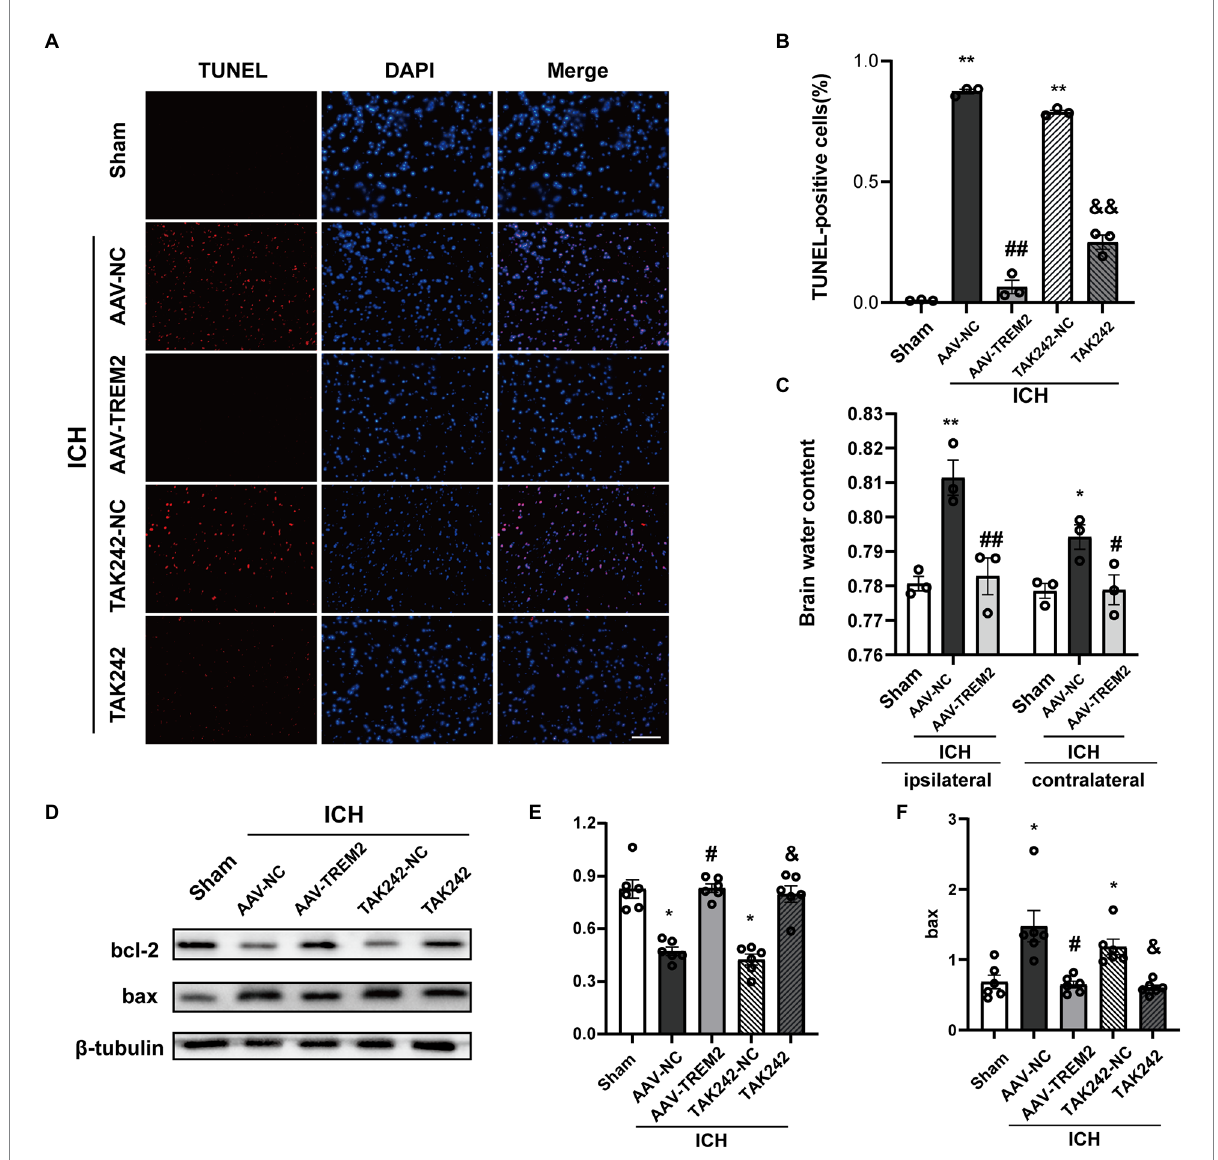
FIGURE 5 TUNEL staining and brain water content following intracerebral hemorrhage. (A,B) TUNEL staining of brain tissue (DAPI: blue, TUNEL: red), and quantitative analysis of TUNEL staining. ** p < 0.01, vs. the sham group, ## p < 0.01, vs. the AAV-NC + ICH group, && p < 0.01, vs. the TAK242-NC + ICH group. (C) Brain water content both in ipsilateral and contralateral hemisphere. ** p < 0.01, vs. corresponding sham group, # p < 0.05, ## p < 0.01, vs. the corresponding AAV-NC + ICH group. (D–F) Expression levels of bcl2 and bax in different treated groups, * p < 0.05, vs. the sham group, # p < 0.05, vs. the AAV-NC + ICH group, & p < 0.05, vs. the TAK242-NC + ICH group. ICH: intracerebral hemorrhage, AAV, Adeno-associated virus; LV, lentivirus; NC, negative controls. Scale bar: 100 μ m. The data were represented as mean ± SEM. n = 3 per